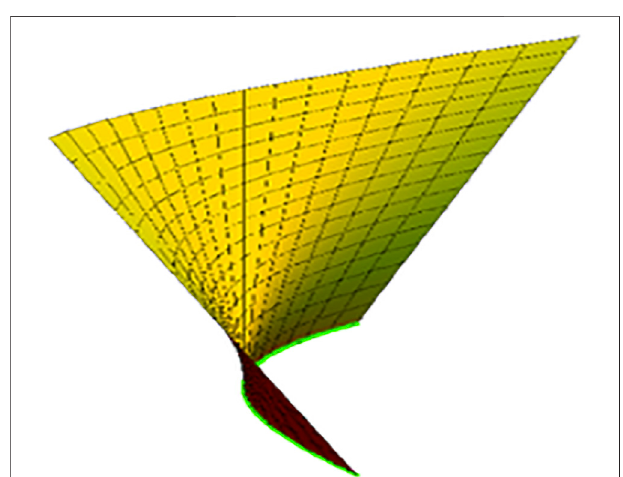
FIGURE 5 | Timelike-ruled surface, with ϑ ( t ) = − t .